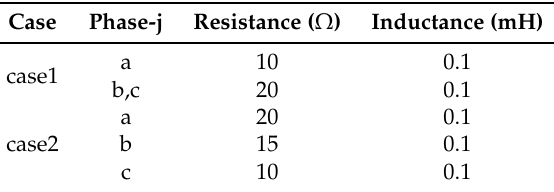
Table 3. Load parameters of the MMC.